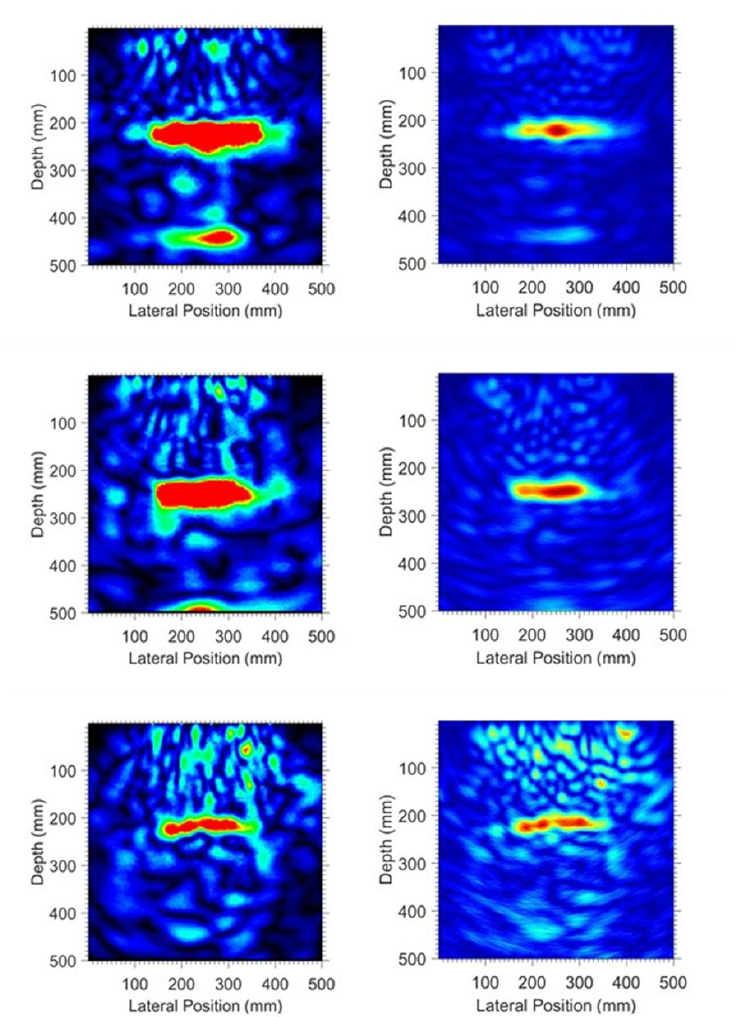
Figure 7. Standard (left) and evaluated (right) images of the other TS’ points (Part